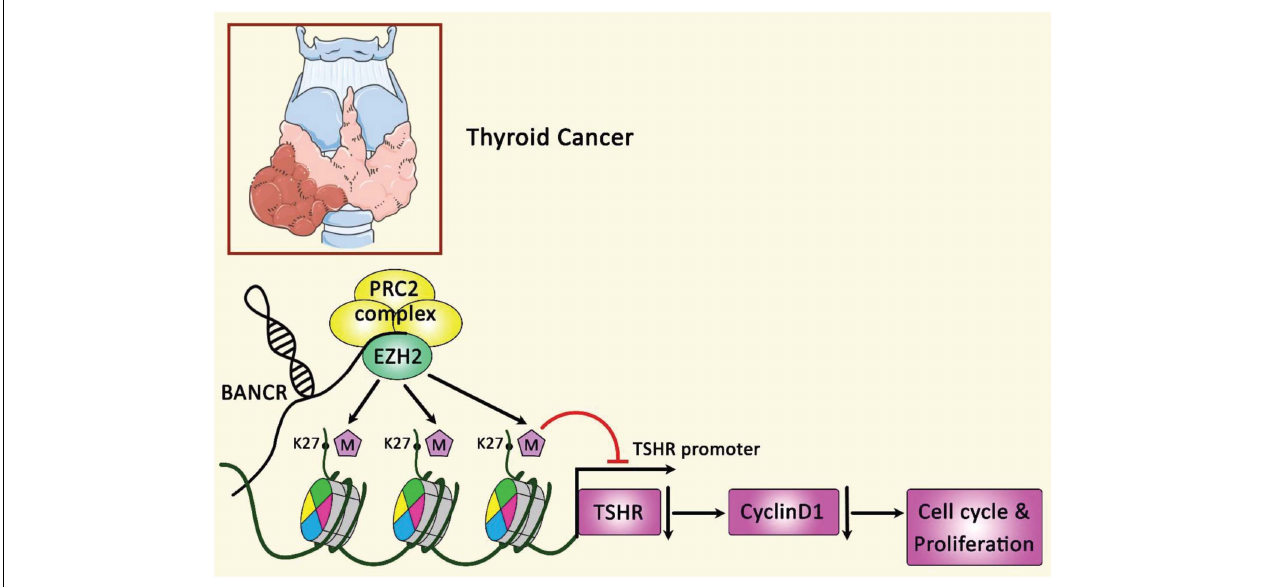
FIGURE 5 | A schematic summary of the role of BANCR and EZH2 modulation on the expression of cyclin D1. LncRNA BANCR could regulate growth and cell cycle of papillary thyroid carcinoma via the modulation of cyclin D1 protein expression. Furthermore, via physical binding of BANCR to EZH2, this lncRNA could regulate TSHR and the following target genes especially cyclin D1 (Zheng et al., 2016). BANCR has an oncogenic role in the modulation of PTC cancer (Zheng et al., 2016).